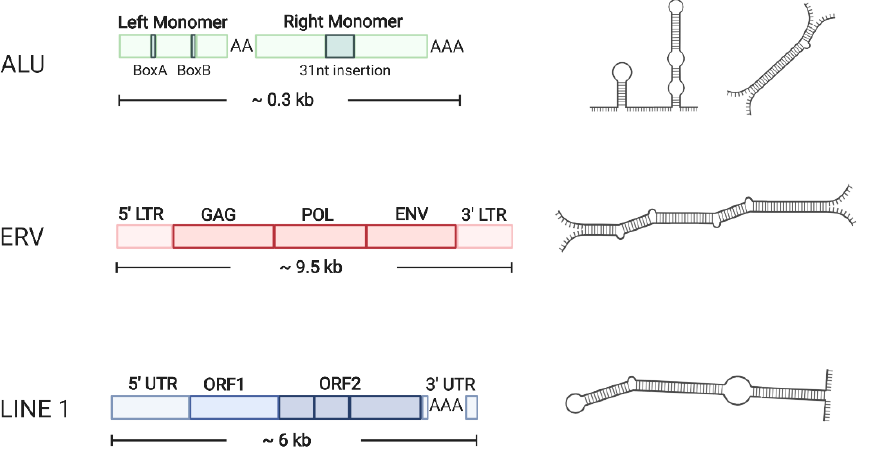
Figure 1. Schematic representation of repetitive elements in the human genome associated with double-stranded RNA (dsRNA) formation. LINE 1 and endogenous retroviruses (ERVs) give potential rise to long dsRNA structures formed from convergent transcripts or hairpin structures from read-through transcription of head-to-head/tail-to-tail arranged elements. Alu elements are much shorter and form hairpin structures as well as “open” dsRNA hybrids, though the intermolecular duplexes are rare. Alu elements are the predominant target for adenosine deaminase acting on RNA (ADAR)-mediated adenosine-to-inosine (A-to-I) editing. LTRs function as bi-directional promoters. ORF, open reading frame; GAG (group specific antigen), POL (reverse transcriptase), ENV (envelope protein), retroviral proteins; UTR, untranslated region; LTR, long terminal repeat. Figure created with Biorender.com.